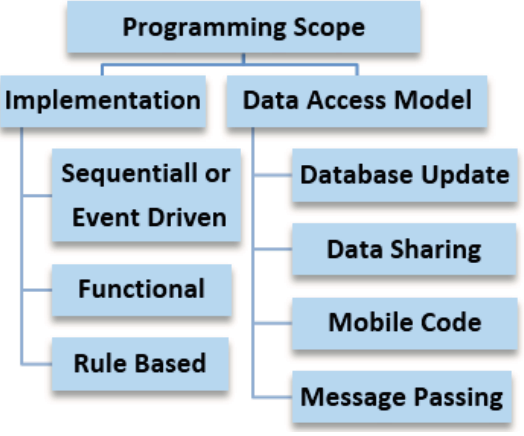
Figure 7. Data processing related programming scope for remote sensor network